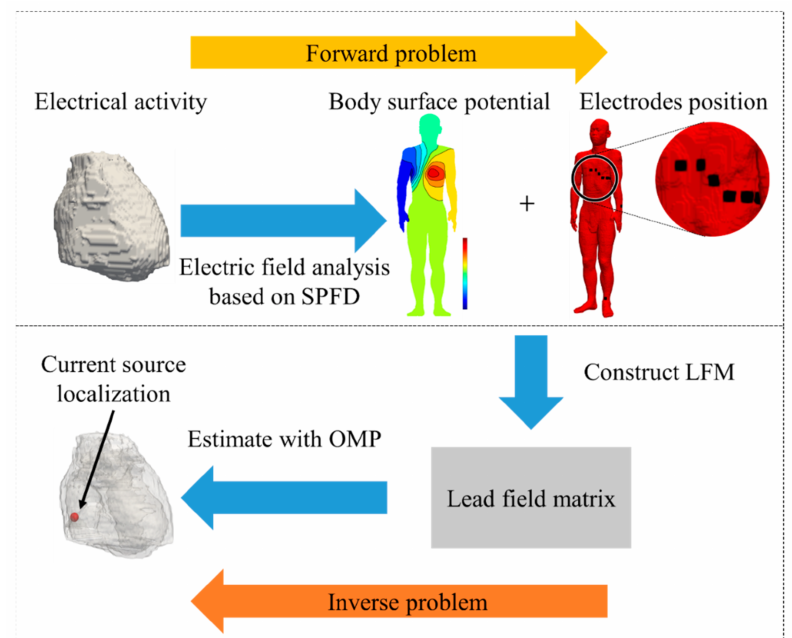
Figure 1. Schematic explanation of the proposed method for cardiac current source